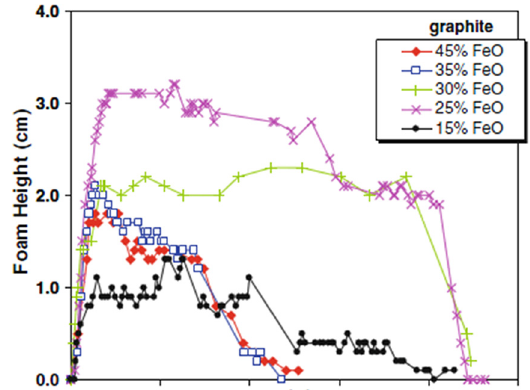
Figure 6: Relationship between slag height and time for different FeO contents.